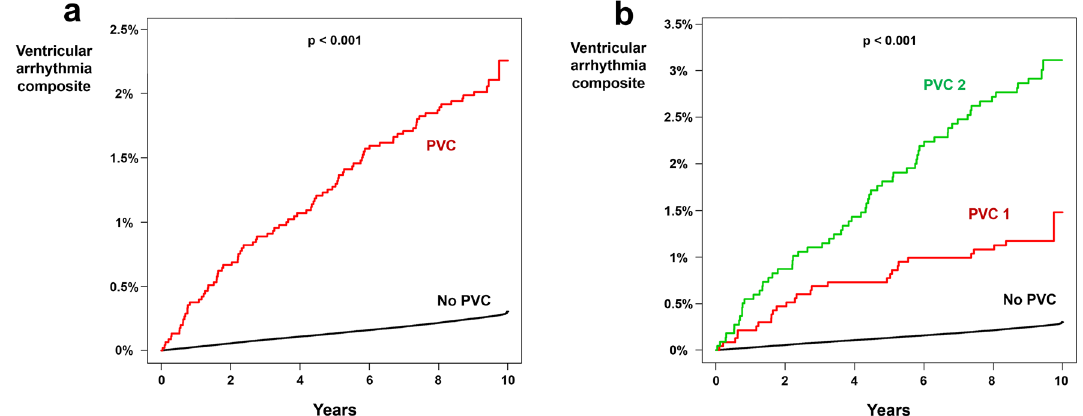
Figure 3. Impact of PVC on ventricular arrhythmia composite. Kaplan–Meier curve analysis showed significantly higher incidence of ventricular arrhythmia composite in people with PVC (a) as compared to people without PVC. People with PVC 2 had an even higher risk of developing ventricular arrhythmia composite (b) . PVC: premature ventricular